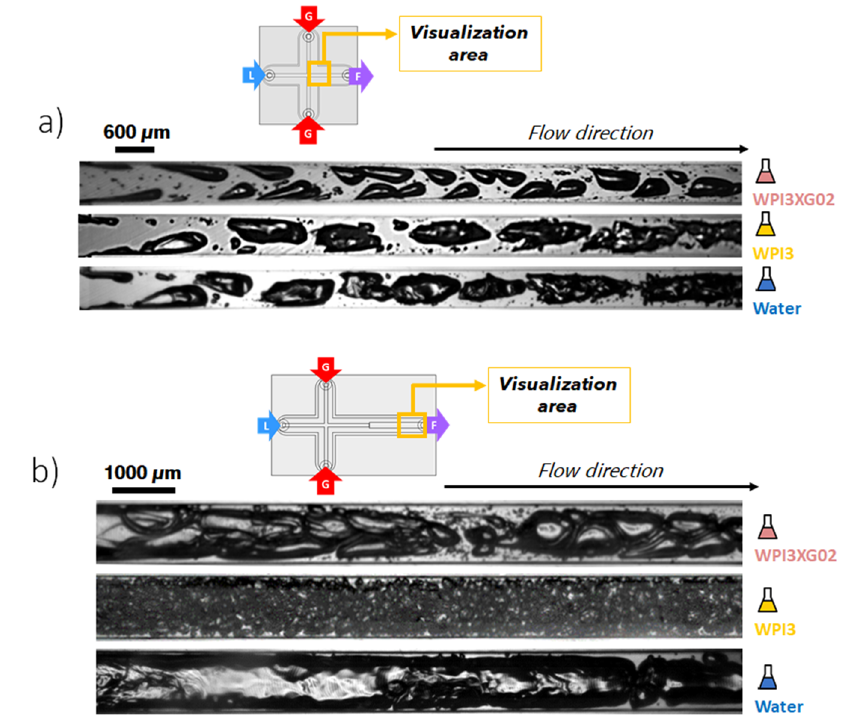
Figure 14. Effect of the formulation on two-phase flow typology. ( a ) High-speed visualizations of the two-phase flow inside the mixing channel of the device CX600 for the solutions WPI3XG02, WPI3 and water at Q vL = 11 L.h −1 and Q mG = 21.6 g.h −1 . ( b ) High-speed visualizations of the two-phase flow inside the expansion channel of the device CX-E-600 for the solutions WPI3XG02, WPI3 and water at Q vL = 3 L.h −1 and Q mG = 5 g.h −1 . Table 6. Hydrodynamic parameters of the two-phase flow in the mixing channel of the microfluidic device CX600 for the solutions WPI3, WPI3XG02 and water at Q vL = 11 L.h −1 -Q mG = 21.6 g.h −1 . Solution